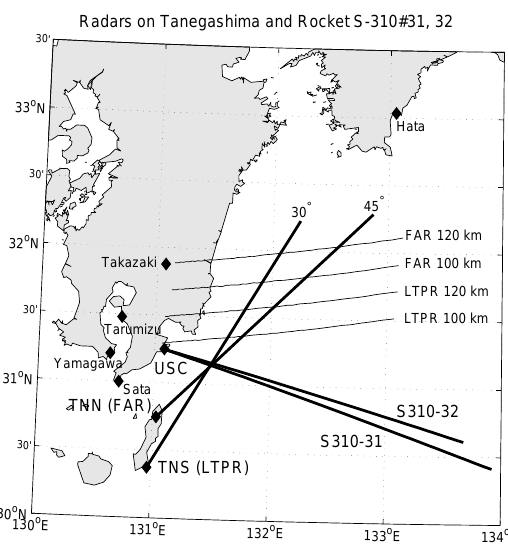
Fig. 1. Arrangement of radar sites, launch site, area observed by radars and rockets. TNS, TNN, and USC stand for Tanegashima South site, Tanegashima North site, and Uchinoura Space Center,